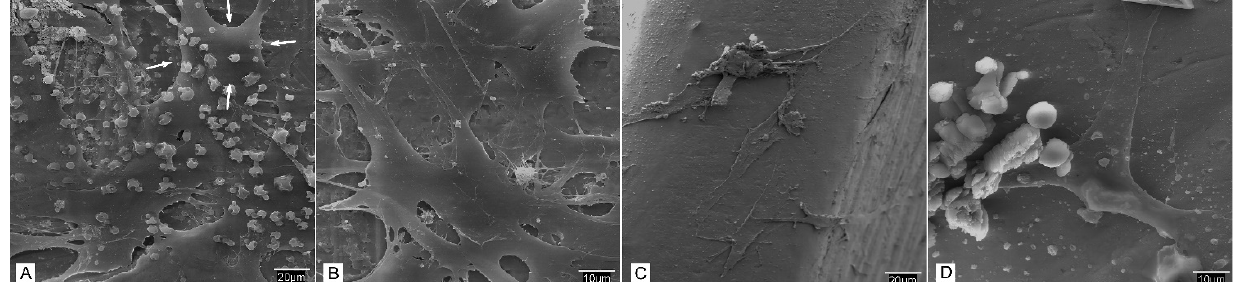
Figure 7. SEM Study of the sowing of fibroblasts in different incubation periods: ( A ) Control screws after 24 h at 500× in which zones are observed where the adhered cells present a more polygonal morphology with many vesicles on their surface (arrows); ( B ) Control screws after 24 h at 1000×; ( C ) Control screws after 28 days at 500×; ( D ) Control screws after 28 days at 1000× in which a large amount of cellular detritus is observed.